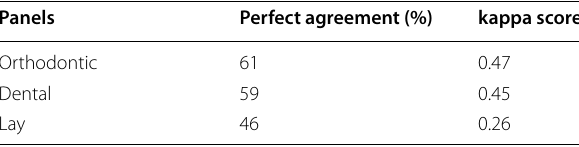
Table 3 Percentages of perfect intra-rater agreement and kappa scores for the panels of judges Panels Perfect agreement (%)